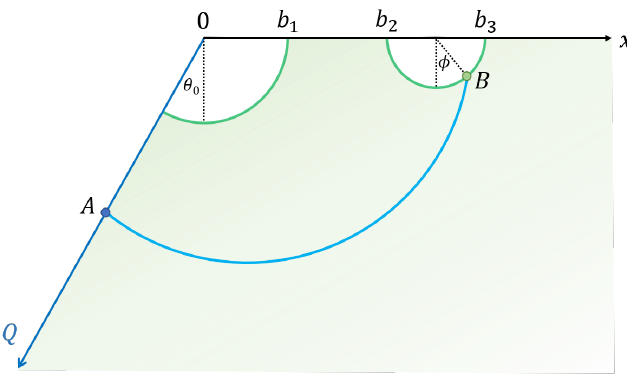
Figure 23. Here we assume φ is positive in the case shown and negative if B is on the left of the vertical dotted line, and we assume θ 0 is a positive